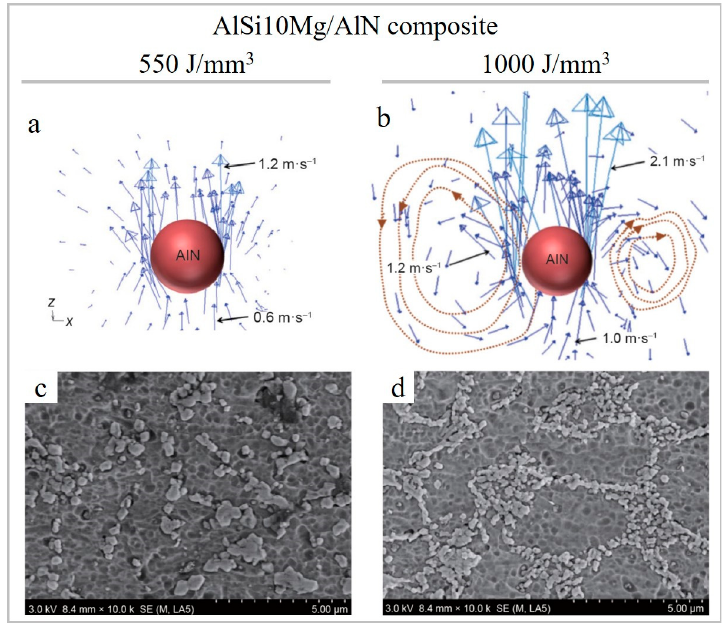
Figure 22. Characteristics of velocity vector obtained around AlN reinforcing particles and their respective distribution state in the solidified Al matrix at E v = 550 J/mm 3 ( a , c ) and E v = 1000 J/mm 3 ( b , d ) (reproduced with permission from [108]).